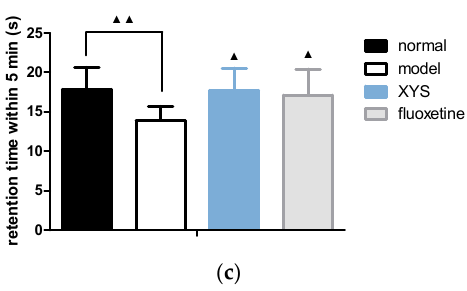
Figure 3. ( a ) Total distance moved; ( b ) numbers of rats entering the central area; ( c ) retention time in the central area. The data were expressed as mean ± standard deviation ( x ± s), n = 10. ▲ p < 0.05, ▲▲ p < 0.01, compared with the model group.